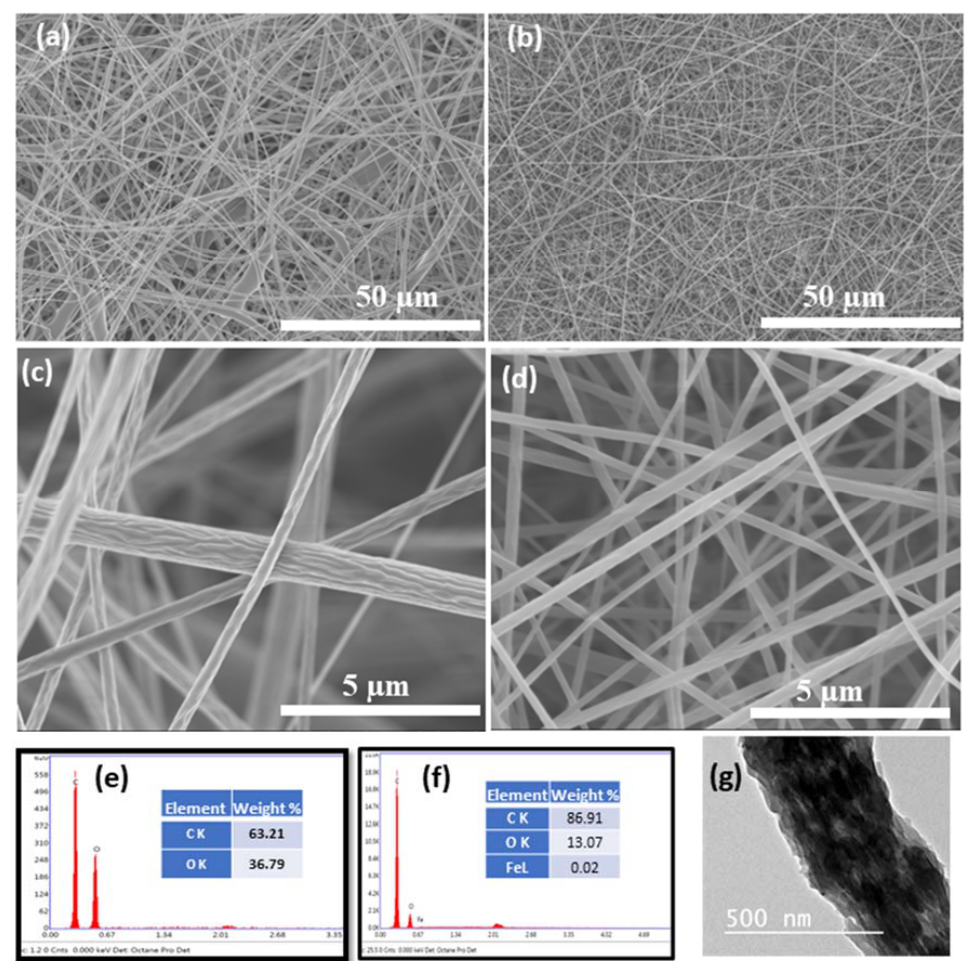
Figure 1. FESEM images of the different mats and EDS point analysis. ( a , c ) CA low and high resolution, and ( b , d ) CA/Fe mats. at low and high resolution ( e , f ) EDS point analysis of both CA and CA/Fe mats. ( g ) TEM image of the CA/Fe mats.